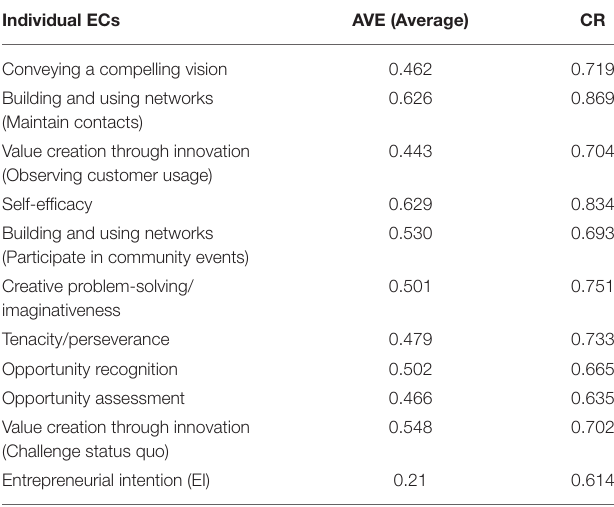
TABLE 2 | Composite reliability (CR)